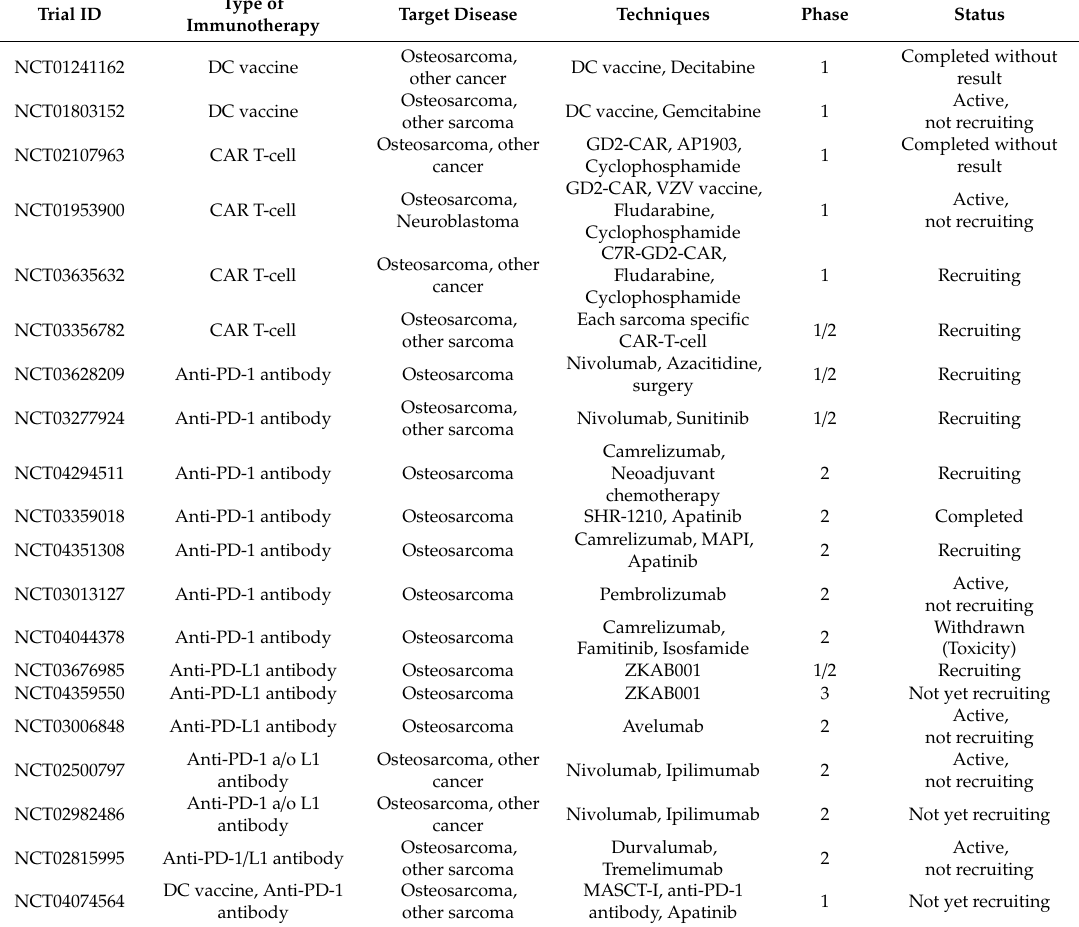
Table 2. Registered Clinical Trials using T-cell Related Immunotherapy for